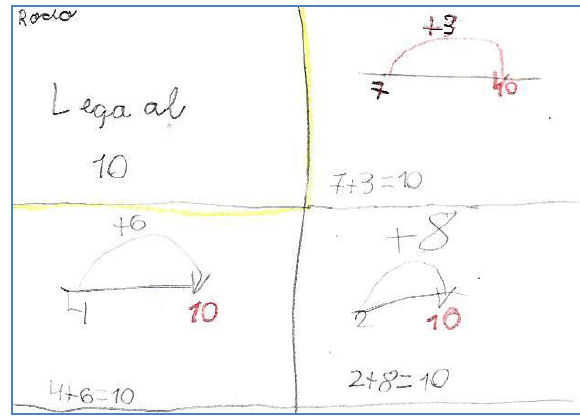
Figure 7. Rocío gets 10.